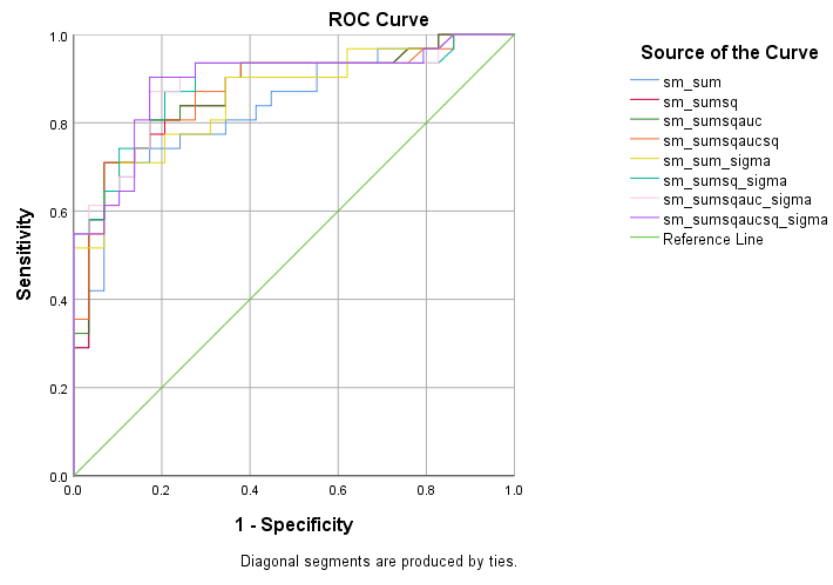
Figure 5. ROC curve analysis of the 8 formulae that better discriminate between Subjective Cognitive Decline SCD and Mild Cognitive Impairment (MCI).